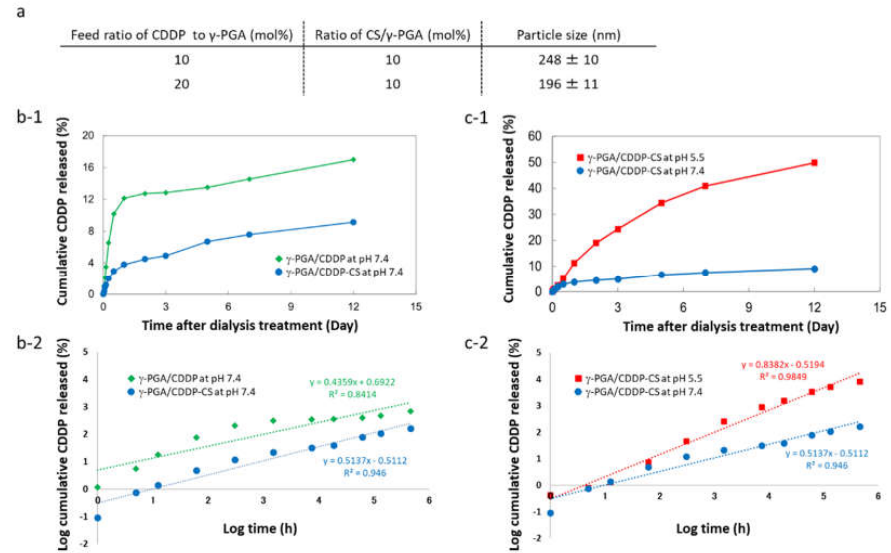
Figure 2. Characteristics of γ -PGA/CDDP-CS. ( a ) Particle size of γ -PGA/CDDP-CS. Data are represented as mean values ± standard error of the mean (SEM). ( b-1 ) Cumulative CDDP released from γ -PGA/CDDP and γ -PGA/CDDP-CS 12 days after dialysis at pH 7.4 was 17.0% and 9.1%, respectively; ( b-2 ) Korsmeyer–Peppas model: The approximate expressions for γ -PGA/CDDP and γ -PGA/CDDP-CS were calculated as y = 0.4359 x + 0.6922 ( R 2 = 0.84) and y = 0.5137 x − 0.5112 ( R 2 = 0.95), respectively. ( c-1 ) Cumulative CDDP released from γ -PGA/CDDP-CS 12 days after dialysis at pH 7.4 and pH 5.5 (70 mM NaCl) was 9.1% and 49.9%, respectively. ( c-2 ) Korsmeyer– Peppas model: The approximate expression for γ -PGA/CDDP-CS at pH 5.5 was calculated as y = 0.8382 x − 0.594 ( R 2 = 0.98). The data shown are for one representative